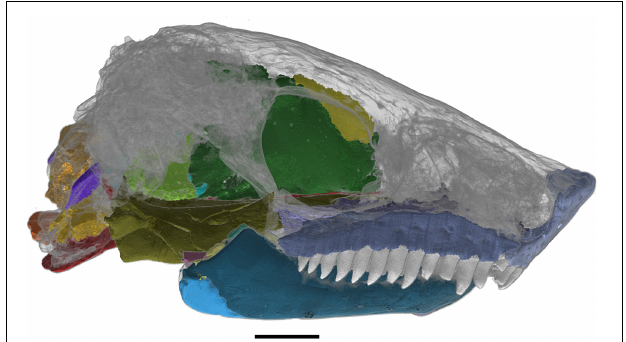
FIGURE 1 | Skull of Nannaroter mckinziei , OMNH 73107, with the elements that were reconstructed using CT data shown. Scale bar equals 2